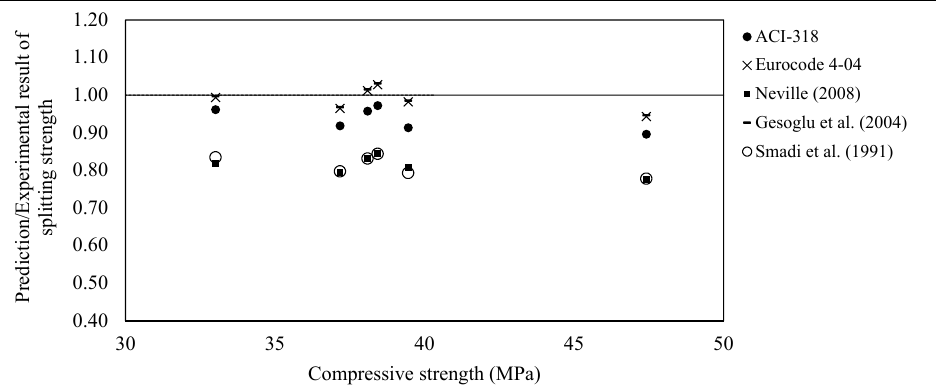
Figure 19. Splitting tensile and compressive strength relationship of POCP concrete. Coatings 2017 , 7 , x FOR PEER REVIEW